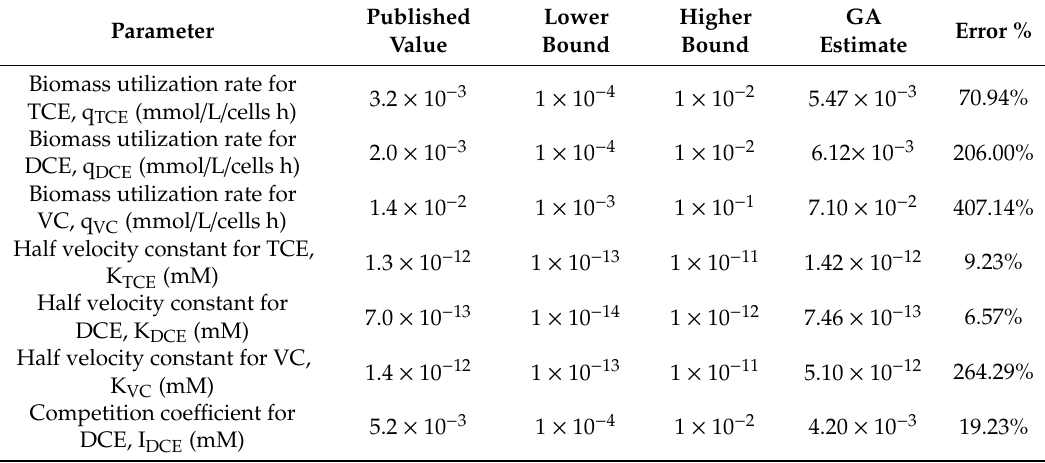
Figure 4. Comparison of experimental results with ( a ) published parameters, ( b ) PGA-estimated parameters for benchmark problem 3. Table 4. Comparison of the PGA-estimated parameters with true solutions along with their bounds for benchmark